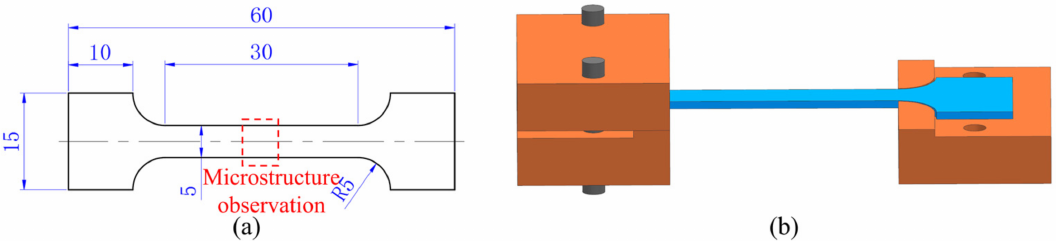
Figure 2. ( a ) Geometry dimensions of the tensile specimens (unit: mm); ( b ) schematic diagram for the clamping